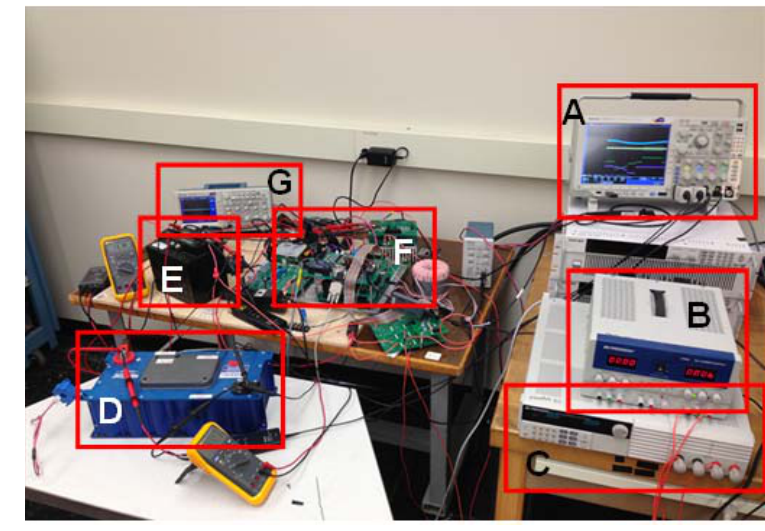
Figure 16. The test platform.